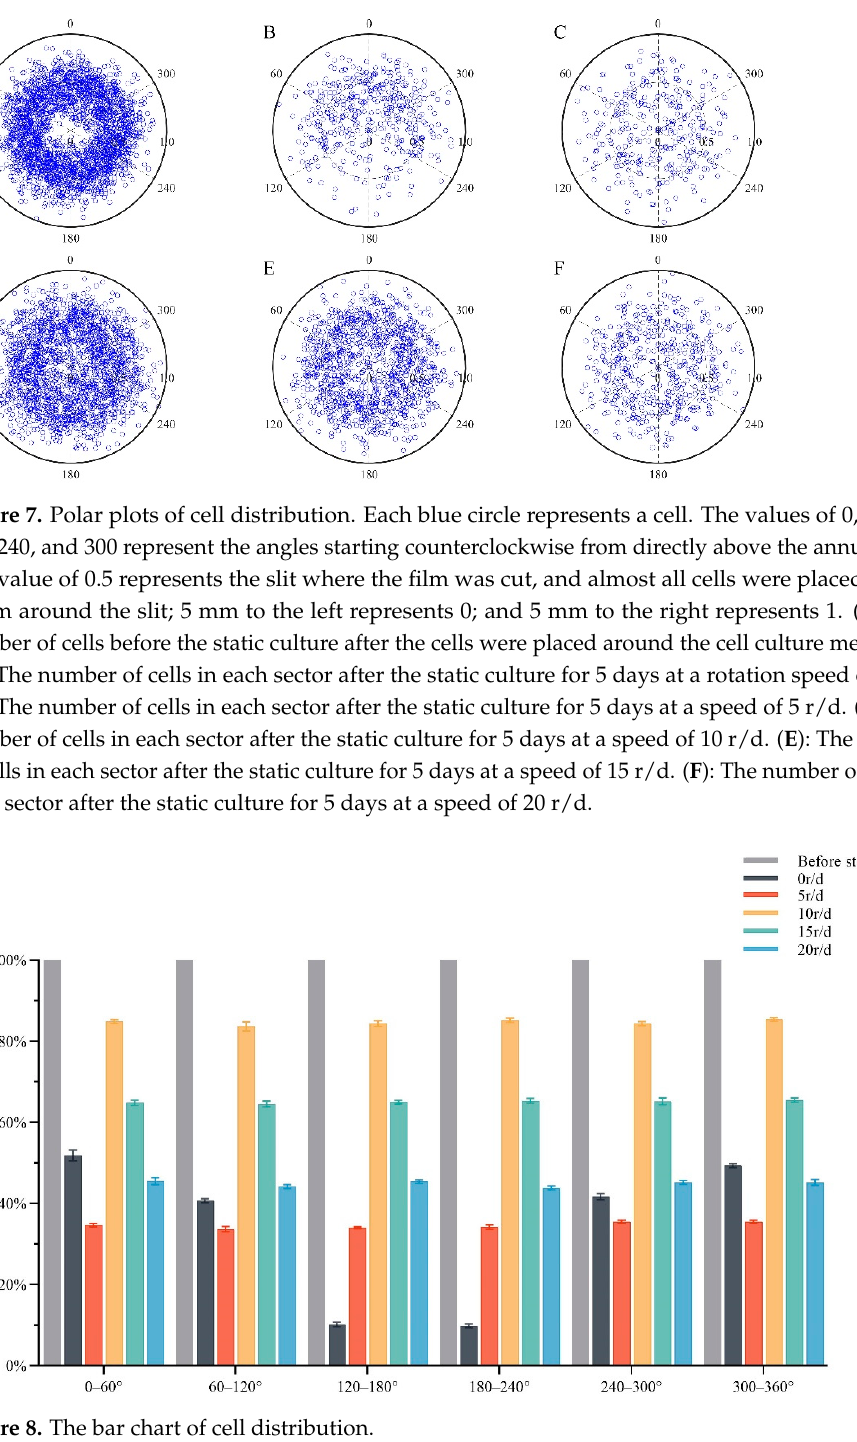
Figure 8. The bar chart of cell distribution. As shown in Figure 8, the number of cells before the static culture was normalized to 100%. When the angular velocity was 0 r/d, the number of cells in the 120–240° sector was the least, the number of cells in the 0–60° and 300–360° sectors was the most, and the number of cells in the 60–120° and 240–300° sectors was next. The number of cells in each sector was significantly different. As the angular velocity gradually increased, the number of cells in each sector also showed a gradual increasing trend. When the angular velocity was 15 r/d, the angular velocity was inversely proportional to the number of cells. At 20 r/d, the number of cells in each sector decreased significantly. When the angular velocity was 10 r/d, the number of cells in each sector was evenly distributed. We measured a 15% decrease between the number of cells after 5 days and the one at the beginning of the experiment. Therefore, when the angular velocity of the cell culture base was 10 r/d, it could not only ensure that the cells adhered to the wall evenly, but also ensured that the number of cells was sufficient. 3.4. Neural Cells Stretch Growth After 10 days of rotation culture with an angular velocity of 10 r/d, the neuron axons spanned the dividing region between the gap of the sheared film. The stepper motor then began to move at a step pitch of 1 μ m per step, giving the cells a rest time of 86.4 s per step. In the process of pulling the culture, the film still maintained a slow rotation speed of 10 revolutions per day, so that the cells could be more fully in contact with the culture medium. After 5 days of the horizontal pulling culture, the axons were not broken. Then, we stained the derived neurons by immunofluorescence to see axons and cell nuclei (Figure 9).